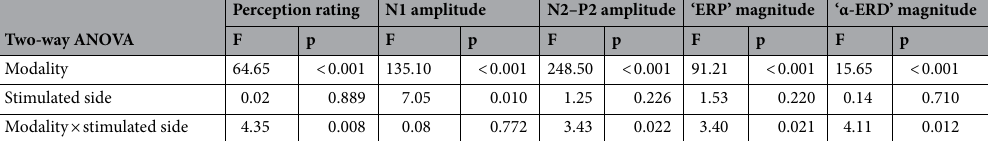
Table 2. Results of two-way repeated-measures ANOVA with two within-subject factors (“sensory modality”: nociceptive somatosensory, non-nociceptive somatosensory, auditory, and visual; “stimulated side”: left and right